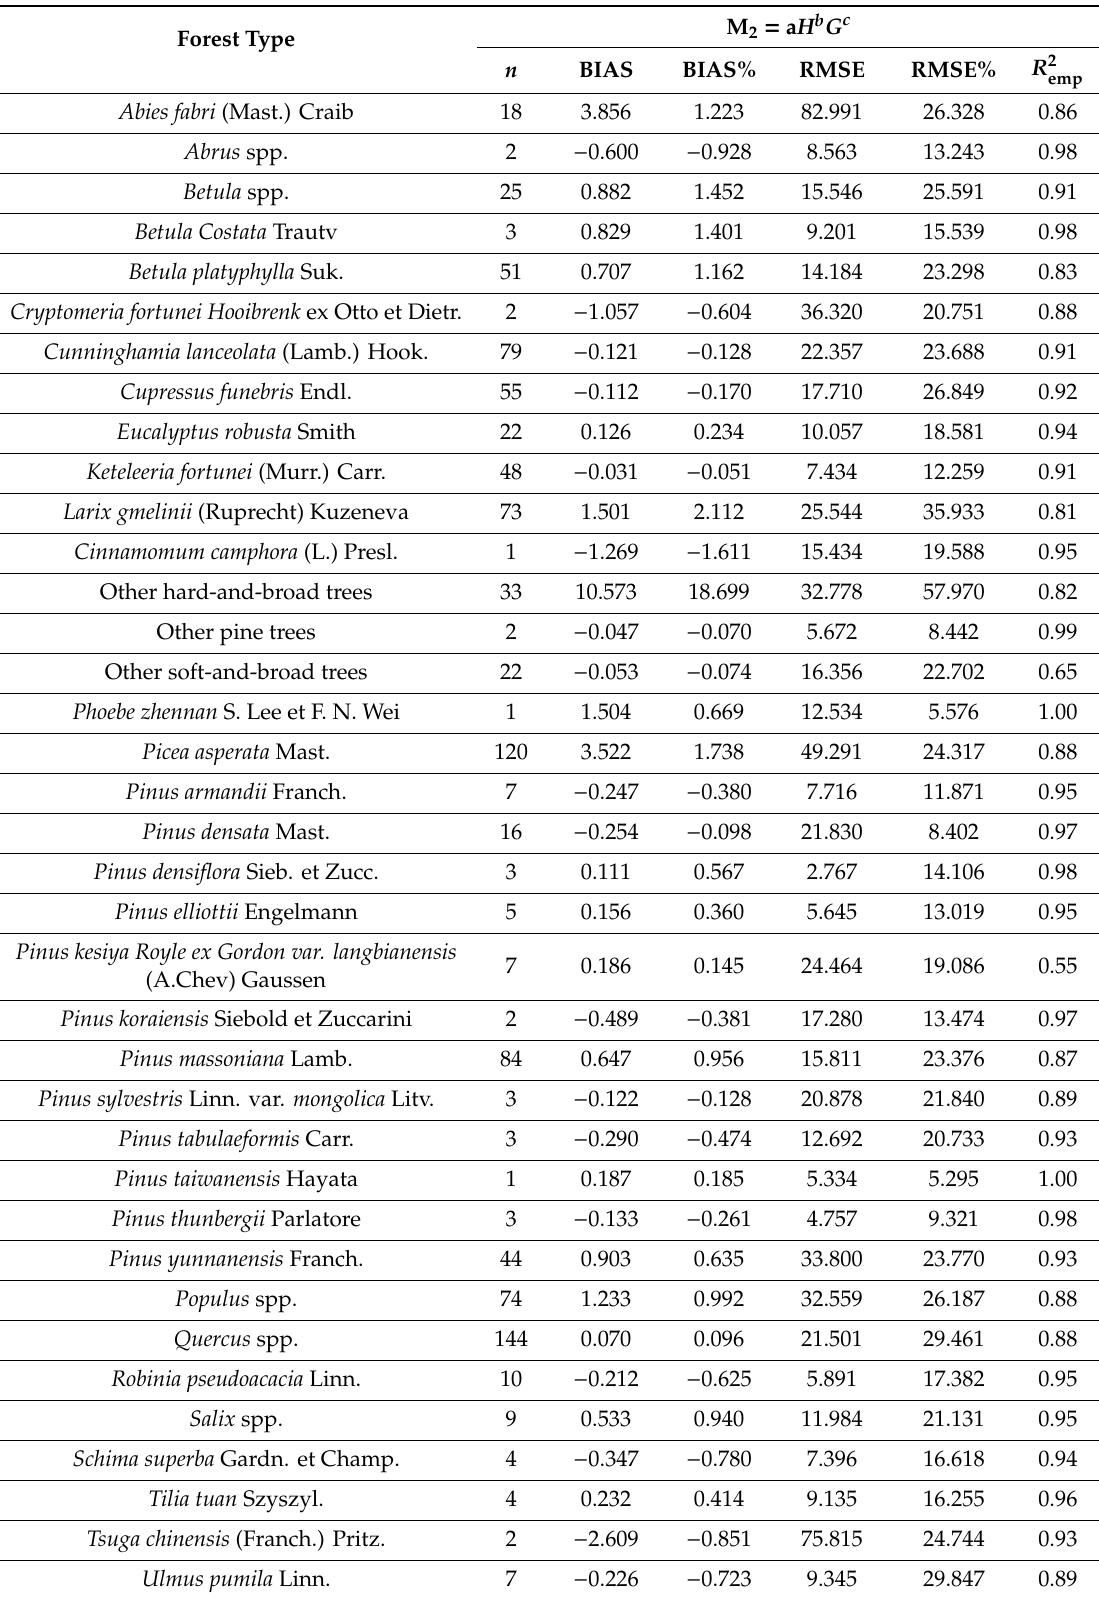
Table 7. Validation of stand volume precision of model 2 for di ff erent forest types. Forest